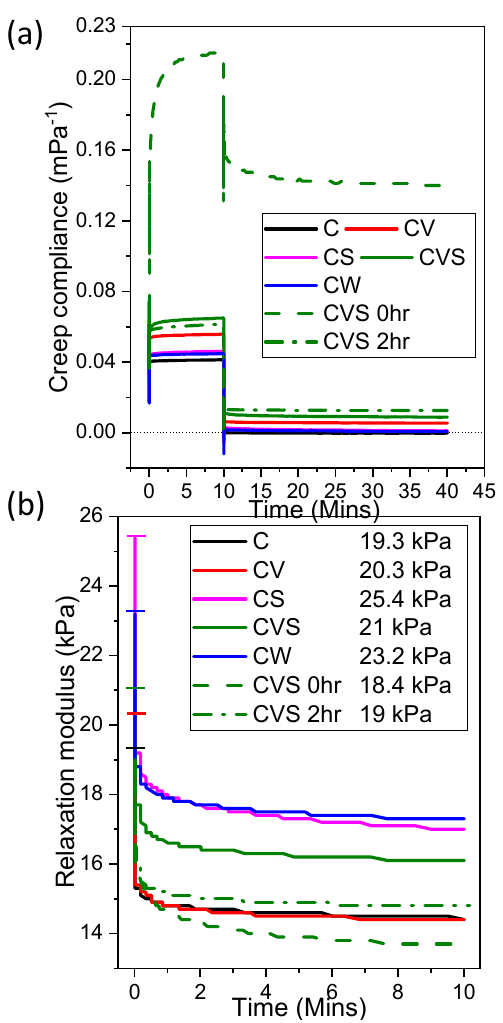
Figure 9. Typical results for (a) Creep and creep recovery and (b) stress relaxation of the concrete mixes at 1 hour concrete age and those of mix CVS at 0 & 2 hours.